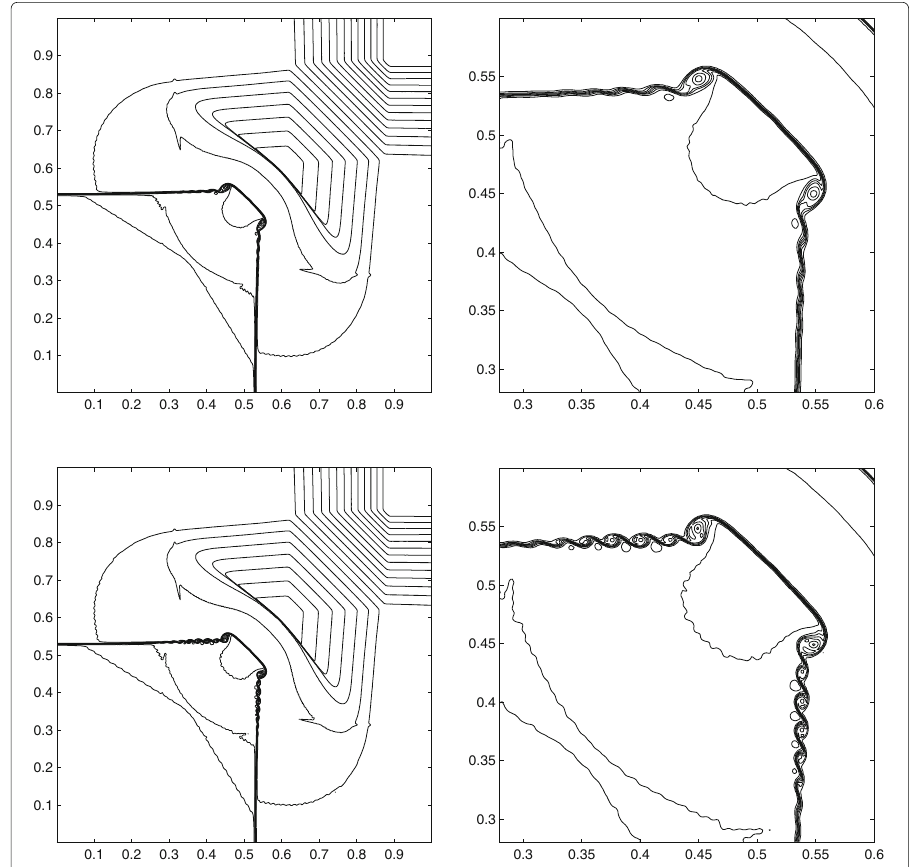
Fig. 4 The density contours of three 2-D Riemann problem in Example 5 computed with the schemes GRP4-WENO5 (upper) and GRP4-HWENO5 (lower), respectively. 700 × 700 cells are